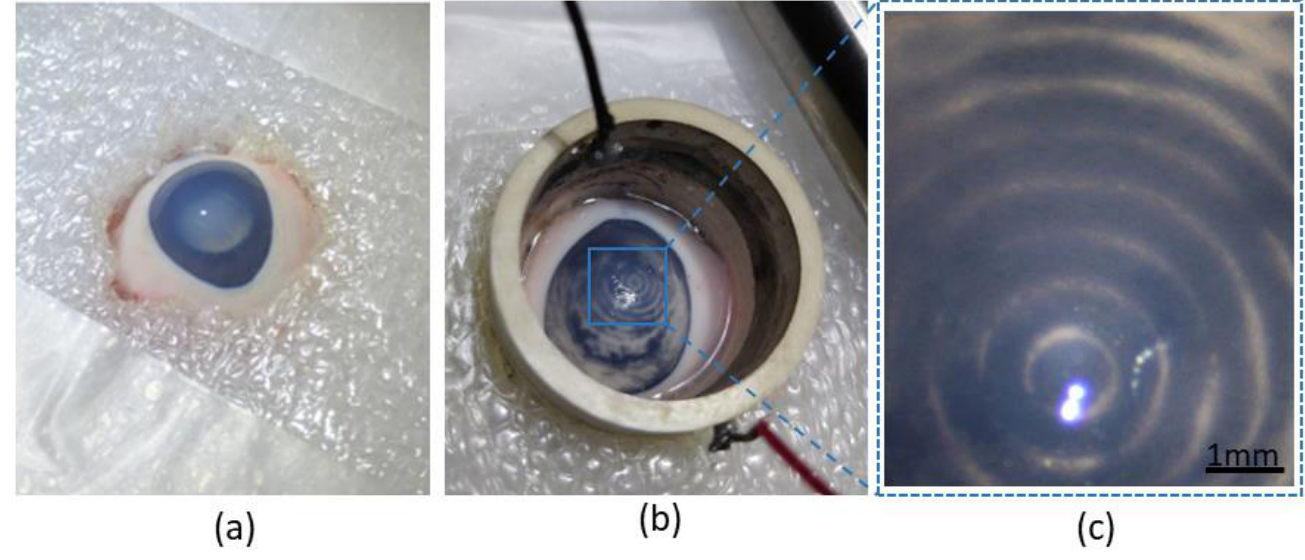
Figure 4. Ex vivo experimental setup: ( a ) fixation of an enucleated pig eye by means of two layers of Styrofoam. ( b ) After injection of the particles, the piezoelectric resonator was placed securely on the eye, and normal saline solution was poured inside until the eye was completely immersed in fluid. A ring arrangement of the triamcinolone acetonide particles within the anterior chamber can be seen. ( c ) Magnified microscope image showing the ring arrangement of porcine pigment particles within the anterior chamber.